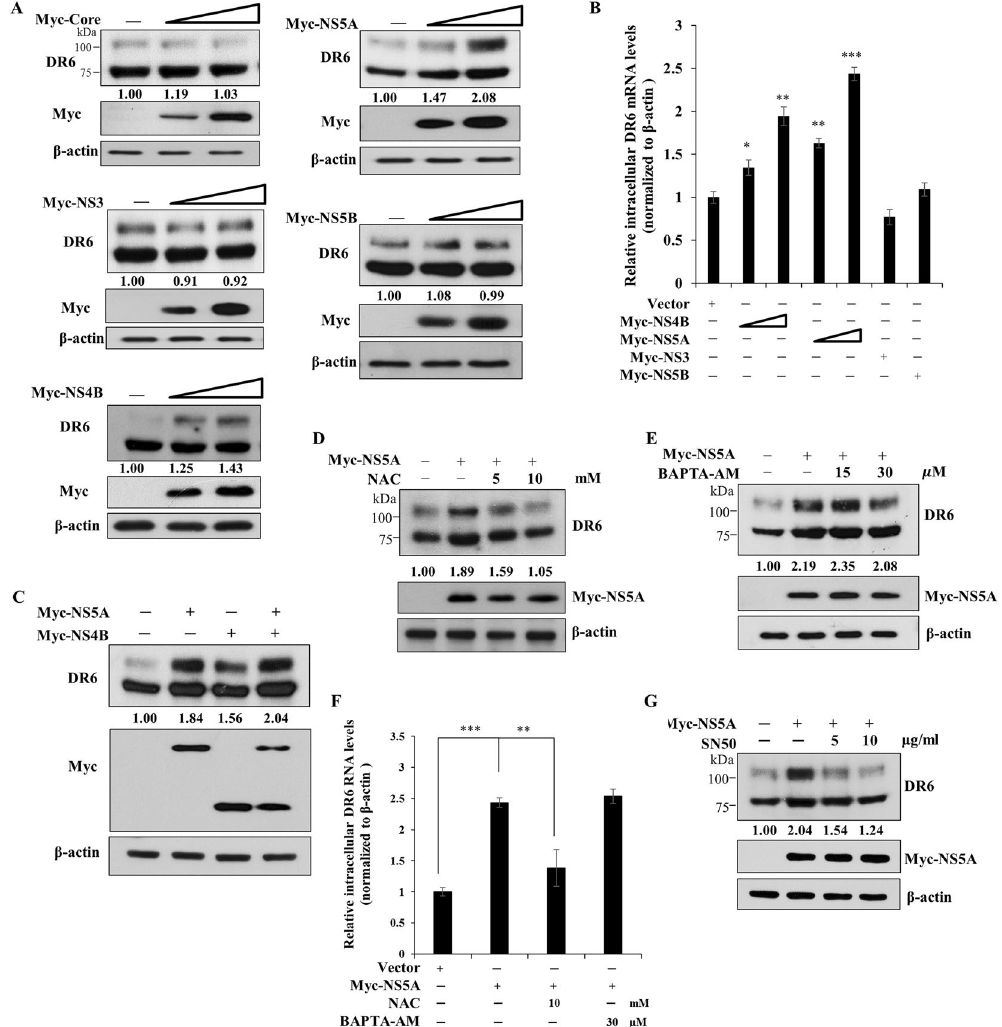
Figure 3. DR6 expression level is mainly upregulated by NS5A protein. ( A ) Huh7.5 cells were transiently transfected with either vector or increasing amounts of Myc-tagged Core, NS3, NS4B, NS5A, or NS5B expression plasmid, individually. At 48 h after transfection, immunoblot analysis was performed to analyze DR6 protein levels. (B ) Huh7.5 cells were transiently transfected with vector or increasing amount of Myc- tagged NS4B or NS5A expression plasmid. At 48 h after transfection, mRNA level of DR6 was determined by qRT-PCR. Experiments were performed in triplicate. The asterisks indicate significant differences ( * P < 0.05, * * P < 0.01, ** * P < 0.001) from the value for the control. ( C ) Huh7.5 cells were cotransfected with Myc-tagged NS4B and NS5A expression plasmids. At 48 h after transfection, immunoblot analysis was performed to determine DR6 protein levels. Protein band intensities were analyzed by using ImageJ. ( D ) Huh7.5 cells were transfected with either vector or Myc-tagged NS5A. At 48 h after transfection, cells were either left untreated or treated with increasing amounts of NAC. At 48 h after treatment, total cell lysates were immunoblotted with the indicated antibodies. ( E ) Huh7.5 cells were transfected with either vector or Myc-tagged NS5A. At 48 h after transfection, cells were either left untreated or treated with increasing amounts of BAPTA-AM. At 48 h after treatment, total cell lysates were immunoblotted with the indicated antibodies. ( F ) Huh7.5 cells were transfected with either vector or Myc-tagged NS5A. At 48 h after transfection, cells were either left untreated or treated with increasing amounts of NAC or BAPTA-AM. At 48 h after treatment, intracellular mRNA levels of DR6 were analyzed by qRT-PCR. Experiments were performed in triplicate. ( G ) Huh7.5 cells were transfected with either vector or Myc-tagged NS5A. At 48 h after transfection, cells were either left untreated or treated with increasing amounts of SN50. At 48 h after treatment, total cell lysates were immunoblotted with the indicated